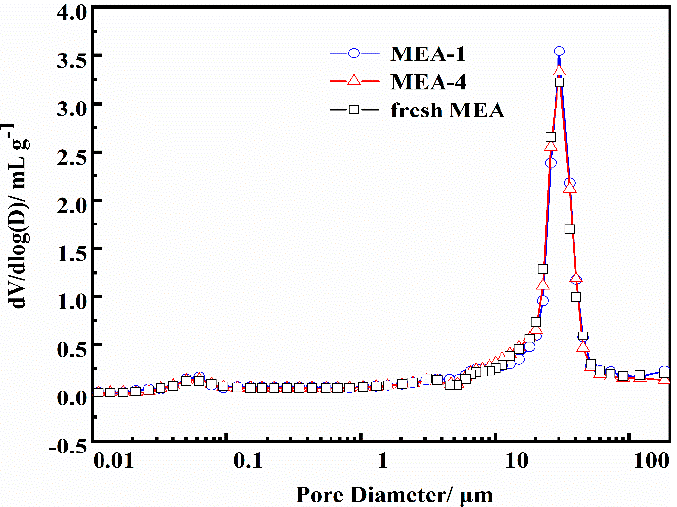
Figure 10. Pore size distribution of the fresh MEA, MEA − 1, and MEA − 4.